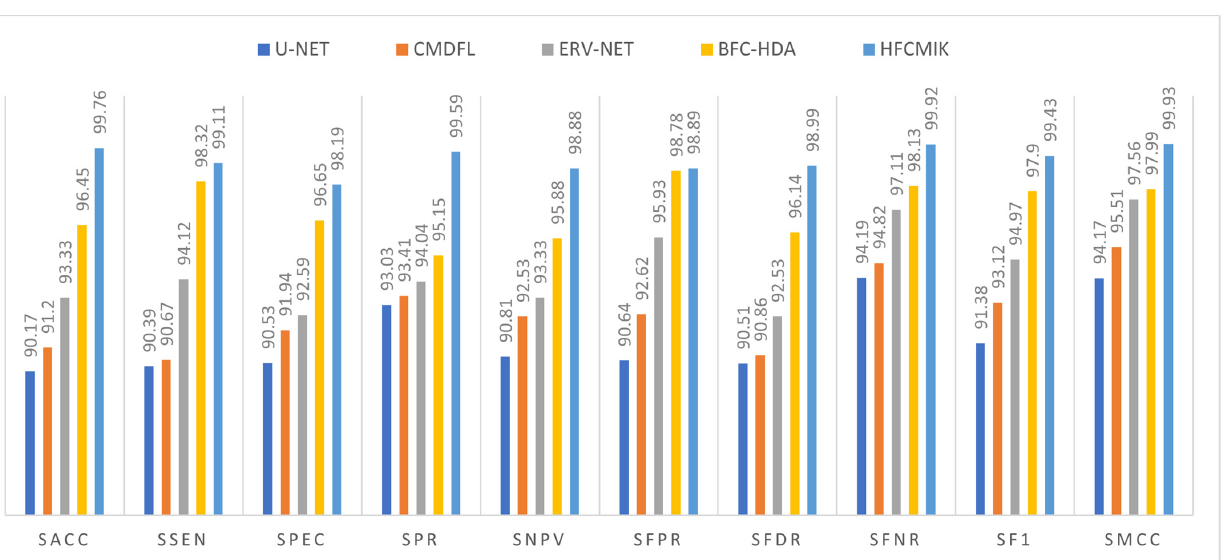
Figure 10. Graphical representation of MR-PET image fusion approaches in percentage (MCA-CS